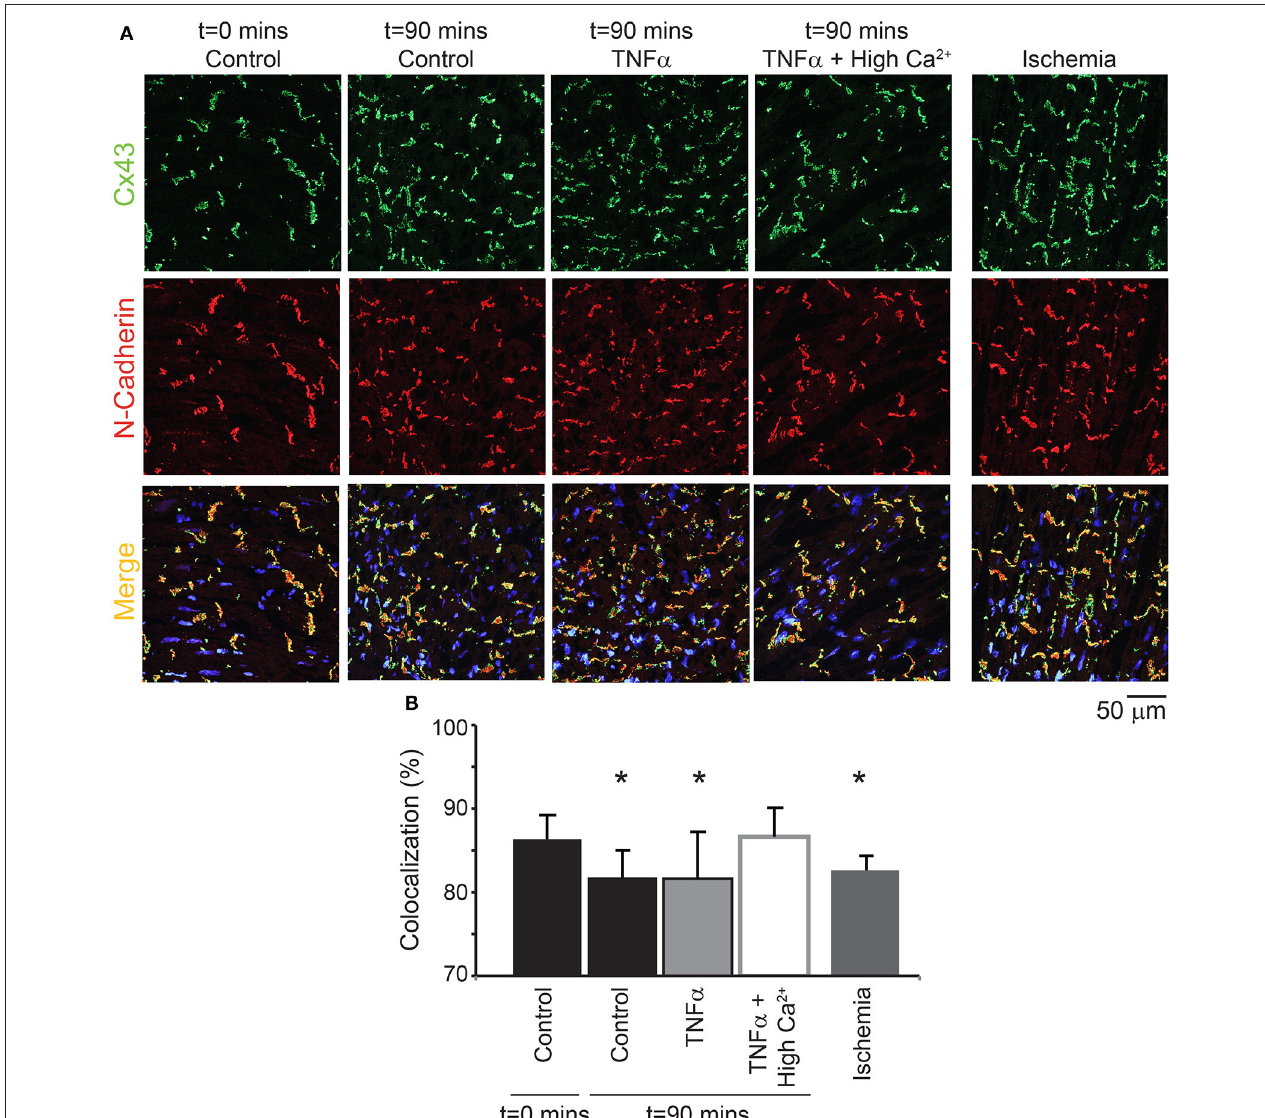
FIGURE 8 | Cx43 distribution modulation by TNF α (A) Representative samples stained for Cx43 (green) and N-Cadherin (red, to mark the intercalated disc). The colocalization of the two signals is indicated in yellow. Samples from control, TNF α , and TNF α + high calcium were compared and 1 h of no flow ischemia was